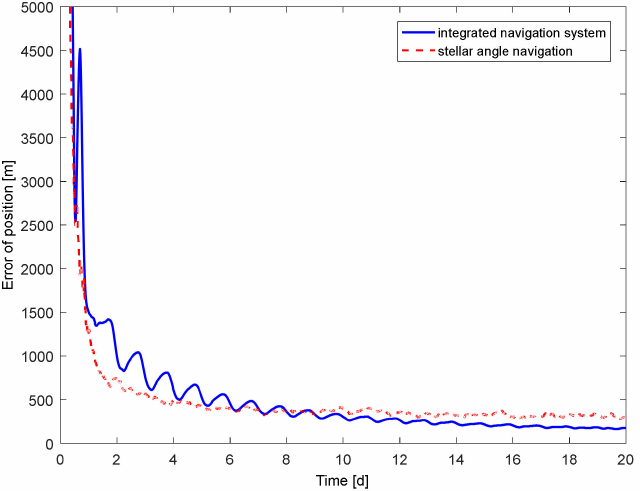
Figure 12. Navigation result of spacecraft